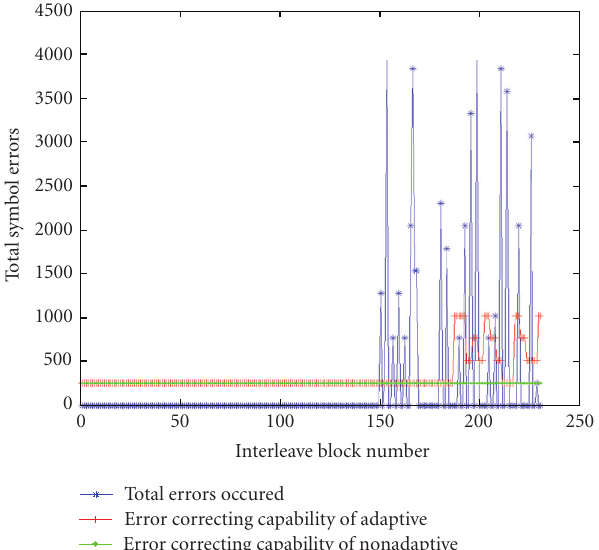
Figure 7: Performance of feedback for “ all” sequence at 32kbps, random delay 0.026, bu ff er size 500, packet size 256, span 16, PL rate 4.9%.